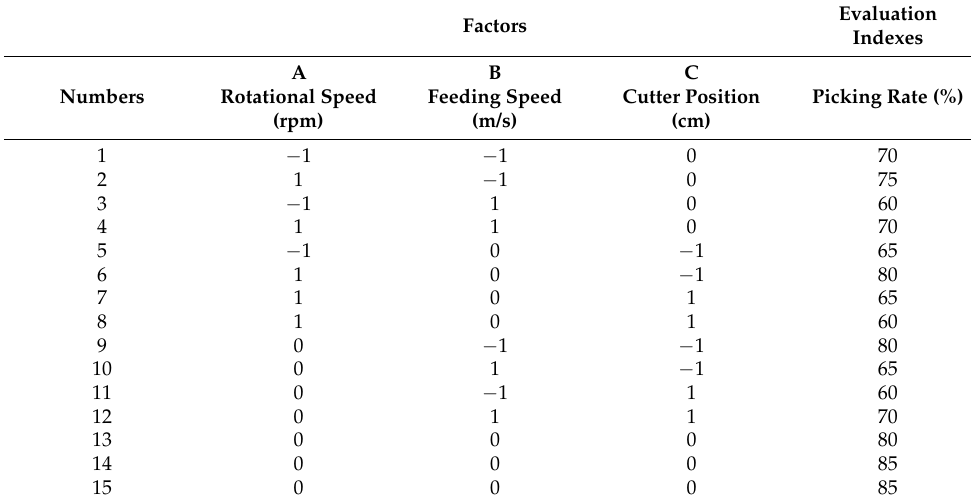
Table 4. Scheme and results of Box − Behnken test.